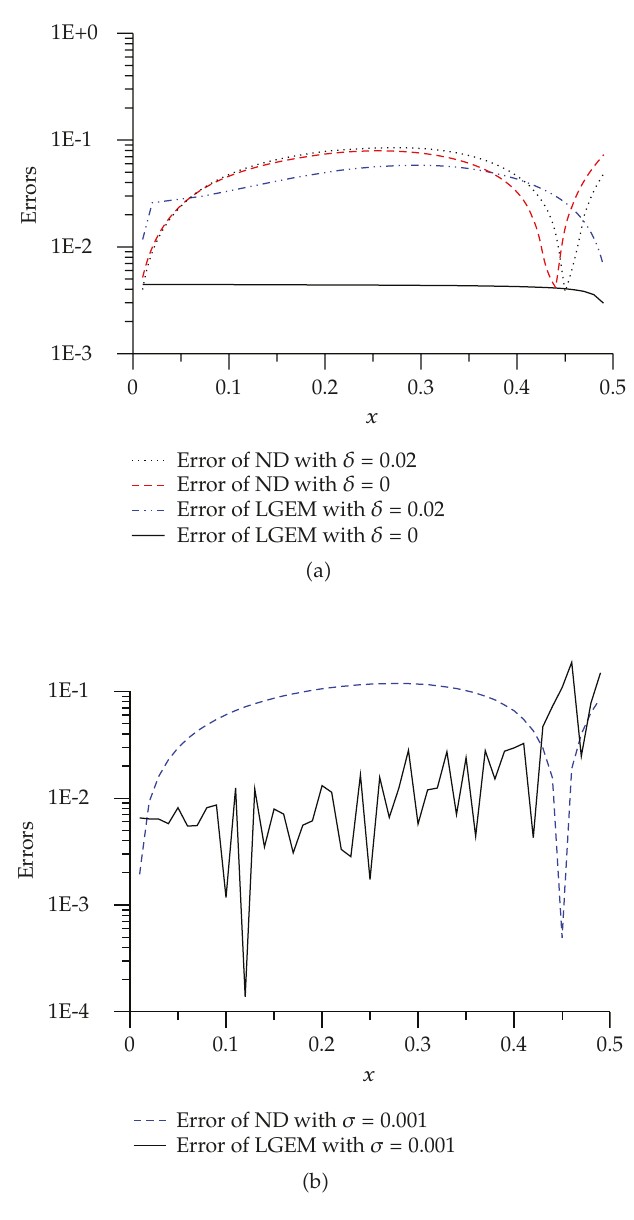
Figure 5: Example 6.5 comparing the estimation errors of p (cid:6) x (cid:7) : (cid:6) a (cid:7) definite disturbances with δ (cid:9) 0, 0.02, and (cid:6) b (cid:7) random disturbance with σ (cid:9)